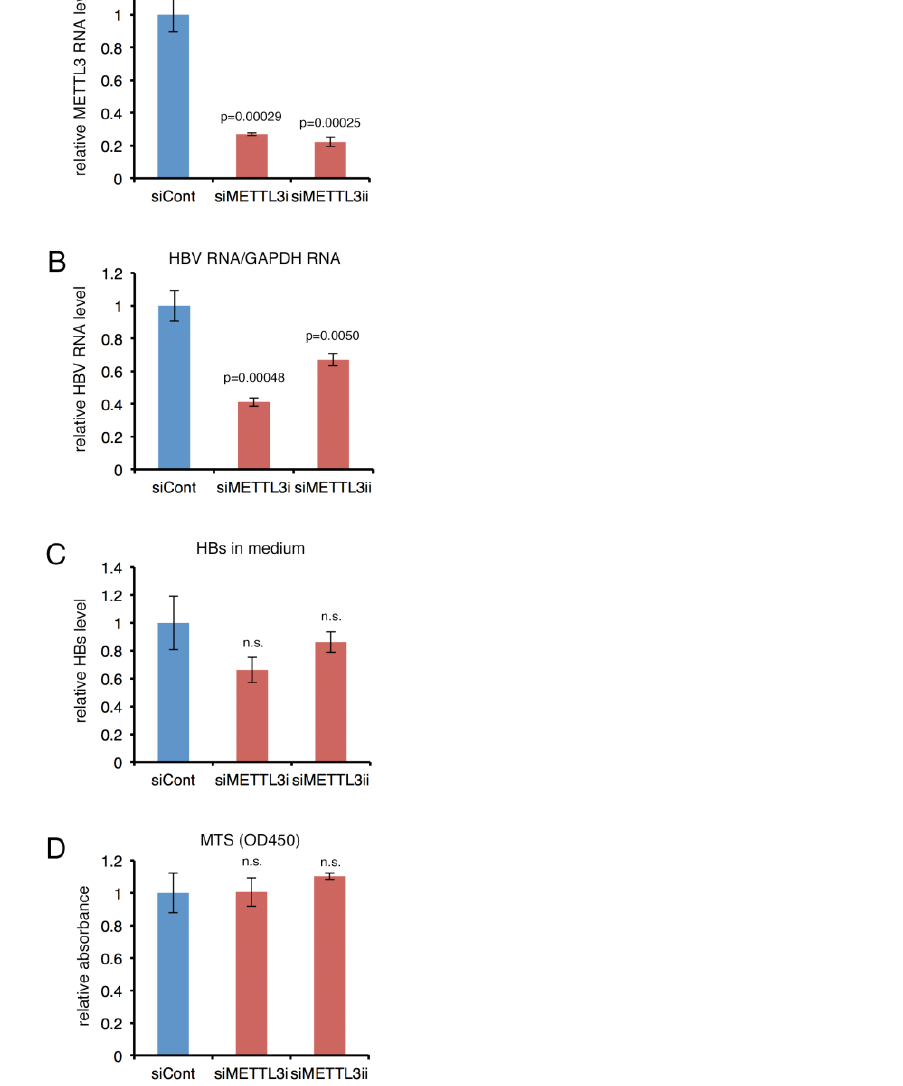
Figure 5. Effect of knockdown of METTL3 in PHH. ( A – D ) PHHs were transfected with a control siRNA (siCont) or siRNA for METTL3 (siMETTL3i, ii). The next day, cells were infected with HBV in the presence of 4% PEG. At 3 days after infection, siRNA was again transfected, and RNA and culture medium were harvested at day 7 for qRT-PCR ( A , B ) and HBs ELISA ( C ), respectively. MTS assay was conducted to examine cell viability ( D ). Means ± standard deviation (SD) of three independent biological replicates are shown. Student’s t -test was used for the